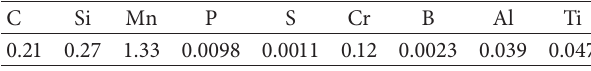
Table 1: B1500HS composition (wt%).